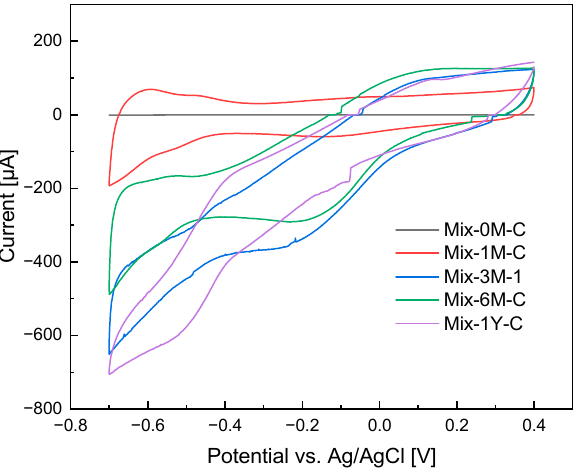
Figure 5. Cyclic voltammograms (CVs) of rice straw ‐ artificial soil mixtures with 0, 1, 3, 6 months, and 1 year of humification (Mix ‐ 0M ‐ C, Mix ‐ 1M ‐ C, Mix ‐ 3M ‐ 1, Mix ‐ 6M ‐ C, and Mix ‐ 1Y ‐ C). All CVs presented here were obtained at the 10th cycle of the measurement. The measurement was carried out using the composite samples except for Mix ‐ 3M ‐ 1.